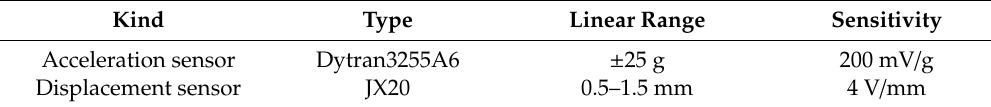
Table 4. Main parameters of two kinds of vibration